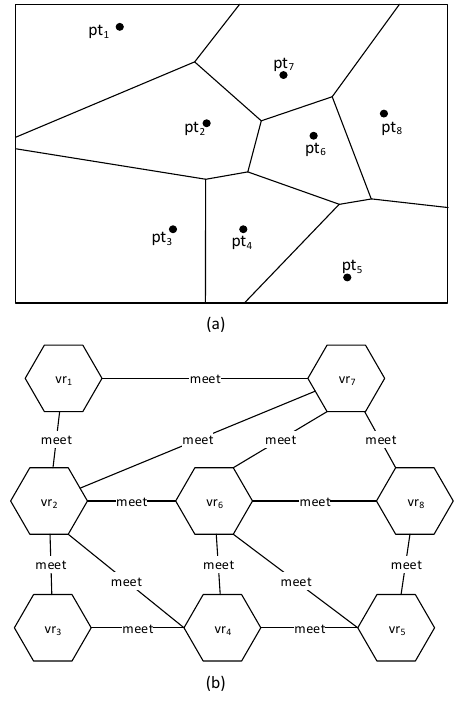
Figure 1. Geographical graph for free space.